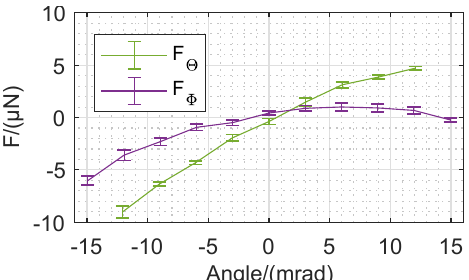
Figure 12. Measured force during tilt about the x axis ( (cid:56) ).